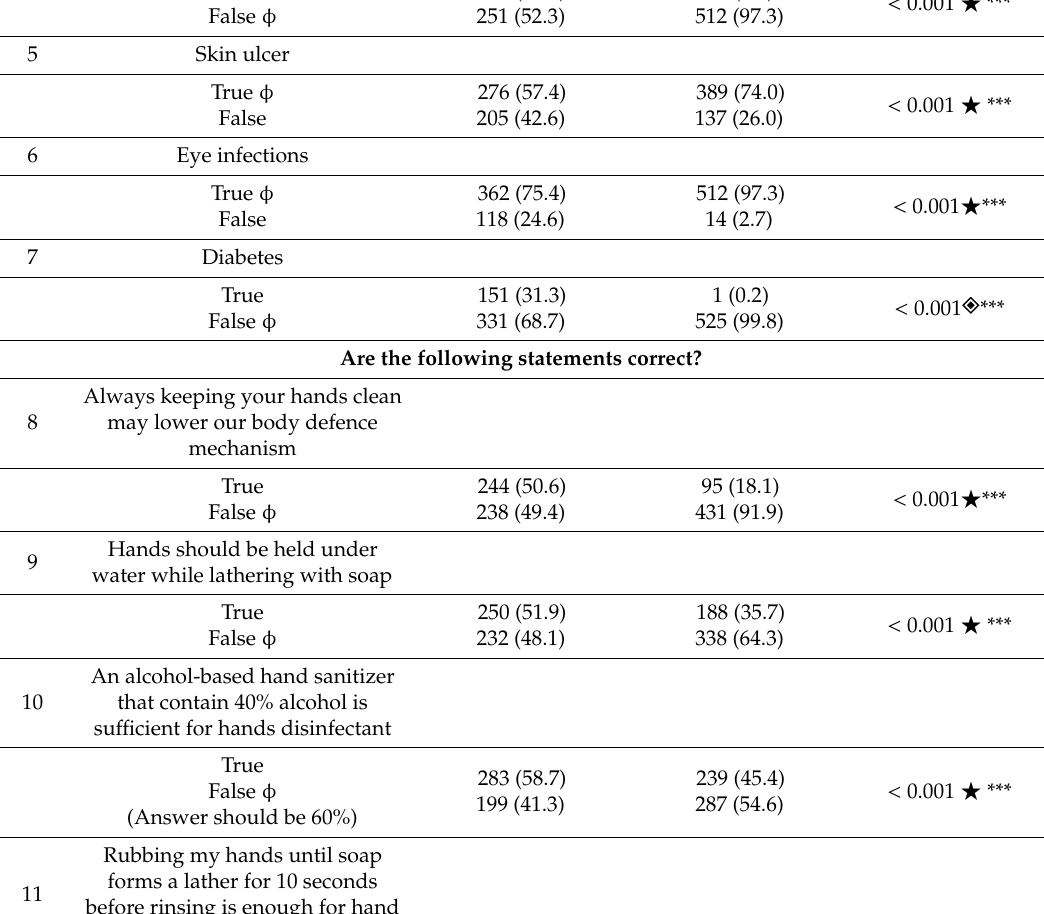
Table 2. Knowledge level on hand hygiene (0 to